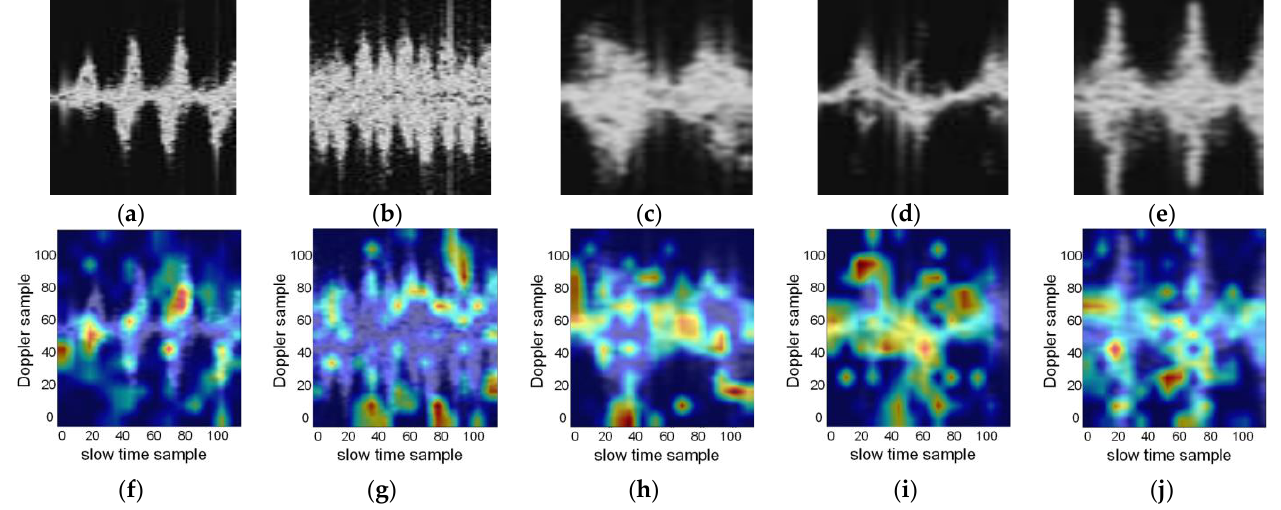
Figure 14. The MDM and feature heatmap of the attention mechanism for the different activities: ( a ) grayscale MDM of label 0; ( b ) grayscale MDM of label 1; ( c ) grayscale MDM of label 2; ( d ) grayscale MDM of label 3; ( e ) grayscale MDM of label 4; ( f ) heatmap of label 0; ( g ) heatmap of label 1; ( h ) heatmap of label 2; ( i ) heatmap of label 3; ( j ) heatmap of label 4.